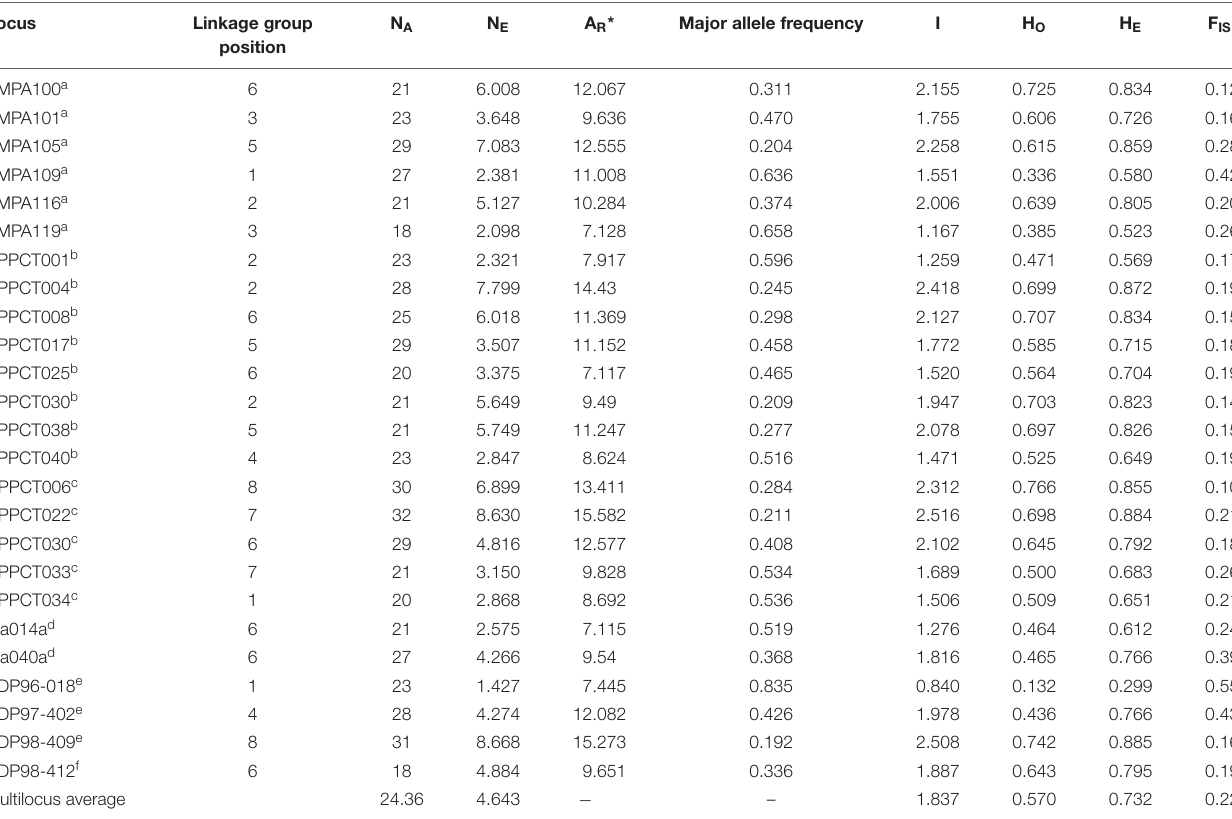
TABLE 1 | Summary statistics of genetic variation at 25 SSR loci in the entire apricot germplasm collection. Locus Linkage group N A N E A R * Major allele position